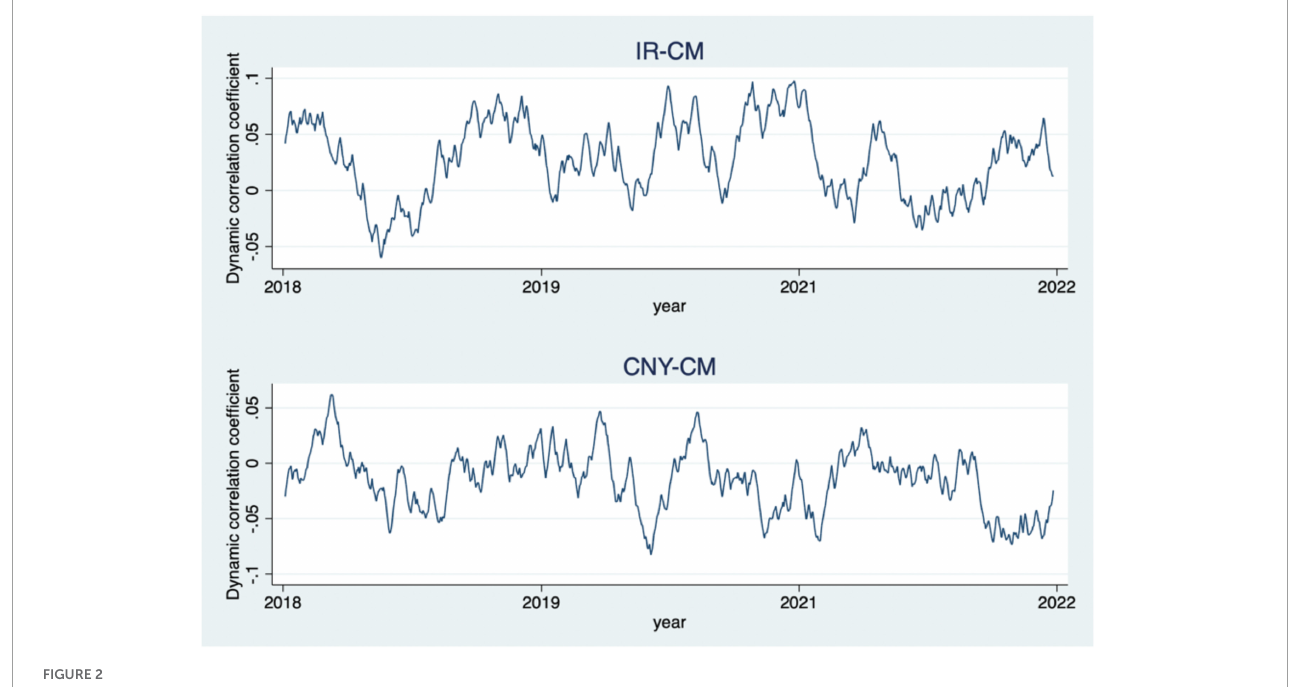
FIGURE2 DCC coefficient diagram.